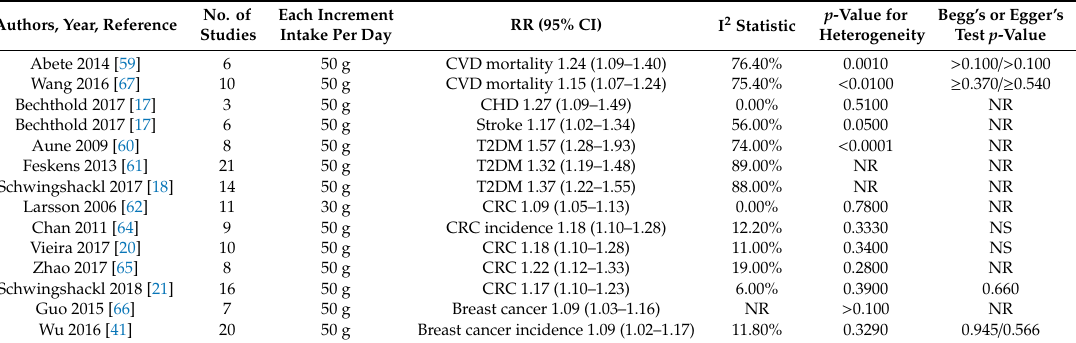
Table 15. Summary of linear dose-response meta-analyses of prospective studies on processed meat intake and CVD, CHD, stroke, T2DM, CRC, breast